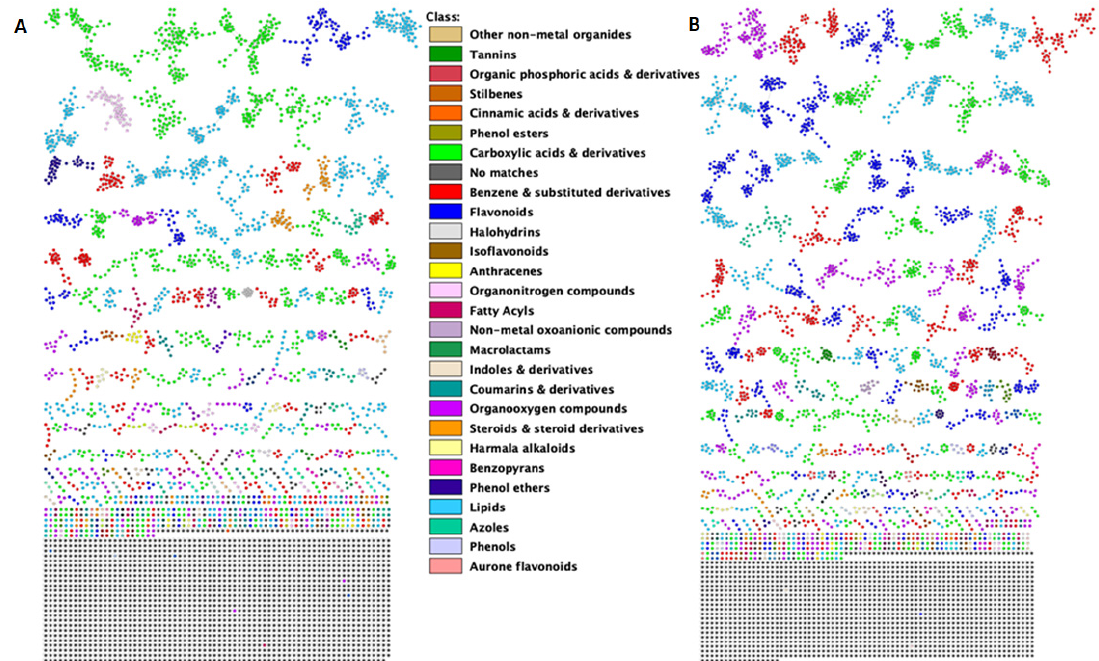
Figure 2. MolNetEnhancer enriched feature-based molecular networks of ( A ) positive electrospray ionization (ESI+) and ( B ) negative electrospray ionization (ESI − ) MS/MS spectra obtained from maize leave extracts. The MolNetEnhancer enriched molecular networks depict structurally similar nodes as molecular families/clusters. GNPS spectral library matched annotations and in silico Network Annotation Propagation (NAP) annotations were used to predict chemical compound class annotations, represented by colored nodes (ClassyFire class ontology terms) with nodes without class annotation colored